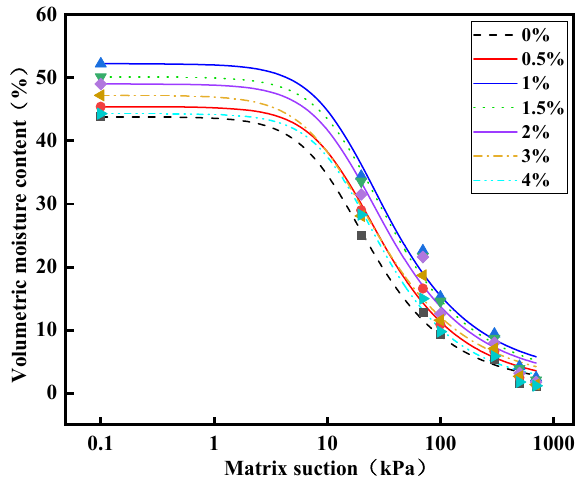
Figure 8. Soil–water characteristic curves of lignosulfonate ‐ improved loess [46].